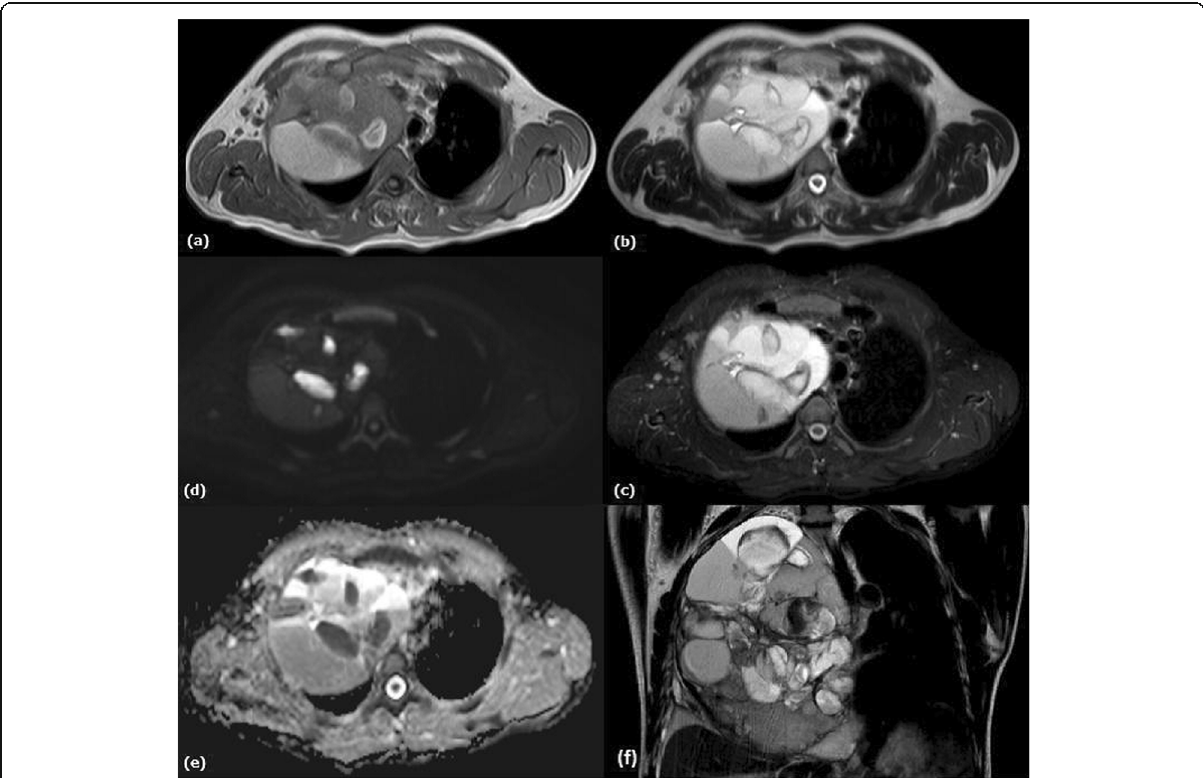
Fig. 11 Angiosarcoma (pathologically proven after thoracotomy and complete excision): A 33-year-old male patient clinically presented with cough, dyspnea, chest pain, and congested neck veins. He underwent MDCT of the chest that revealed an anterior mediastinal mass encroaching upon the right hemithorax. a Axial T1 WI, b and f axial and coronal T2 WI and c STIR WI show a large well-defined rather ovoid-shaped anterior mediastinal mass encroaching upon and occupying most of the right hemithorax. It displays heterogeneous signal on all pulse sequences with fluid-fluid levels reflecting different ages of blood with no sizeable non-hemorrhagic solid components. A contralateral shift of the mediastinum is noted. Associated findings: ipsilateral pleural thickening and minimal pleural effusion. d DWI and e ADC map: not assessed because of the lesion ’ s overall hemorrhagic nature with no definite soft tissue components as apparent on the conventional MR